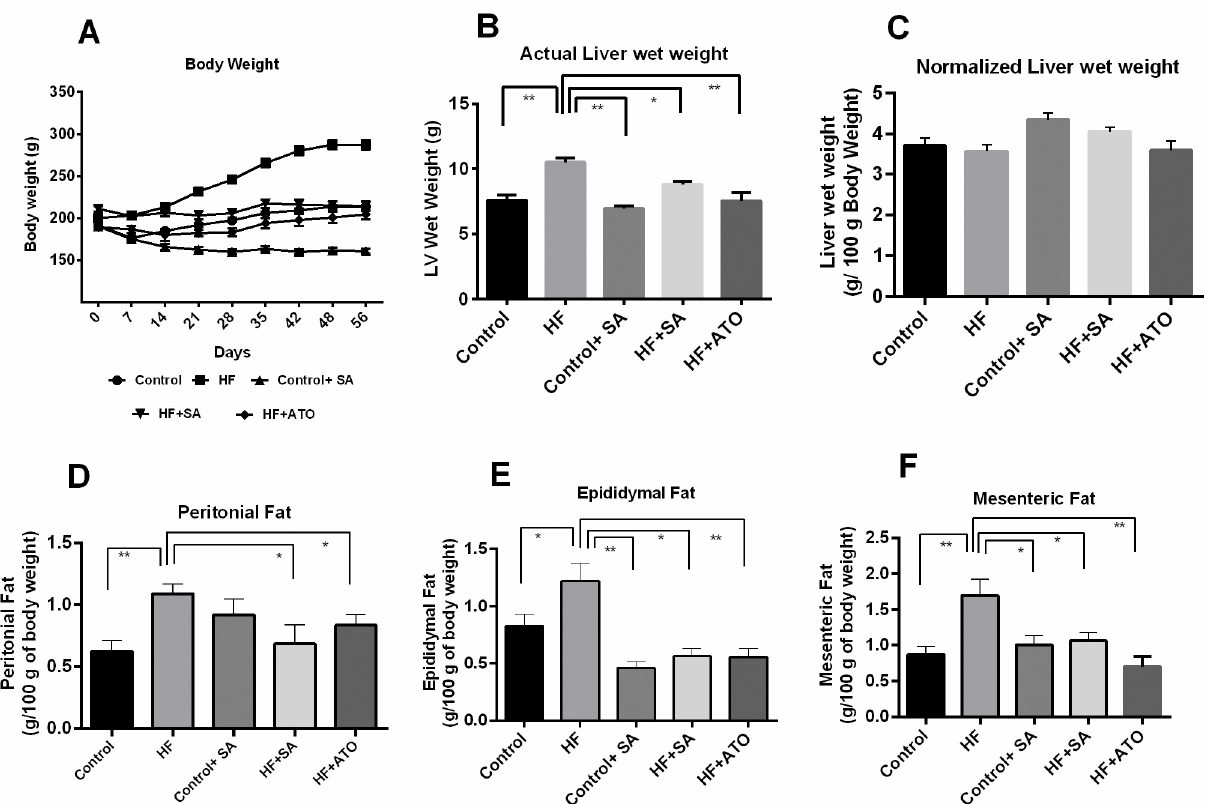
Fig 1. Effect of Senna alexandrina leaf powder supplementation on body weight and fat deposition in high-fat diet-induced obese rats. A. body weight gain; B. Actual liver wet weight; C. Normalized liver wet weight; D. Peritoneal Fat; E. Epididymal Fat and F. Mesenteric Fat deposition in high fat diet induced obese rats. Data are presented as mean ± SEM, n = 8. For statistical analysis, one-way ANOVA with Tukey’s multiple comparison test was performed. � represents p � 0.05; �� represents p � 0.01.